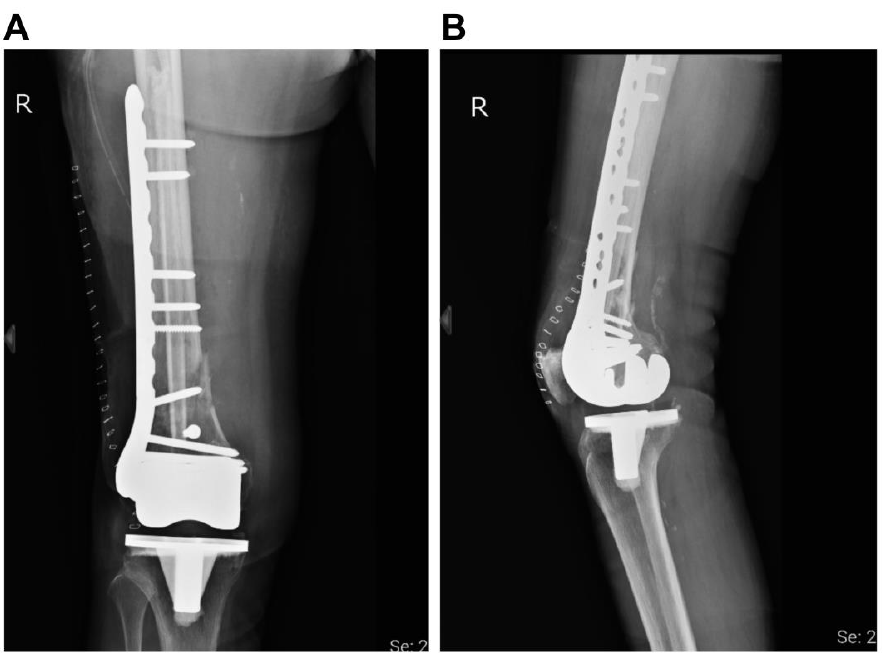
Figure 3. Postoperative radiographic images. ( A ) Anteroposterior (AP) view of knee. ( B ) Lateral view of knee. The periprosthetic distal femur fracture is fixed with a locking plate and an allogenous fibula bone graft.